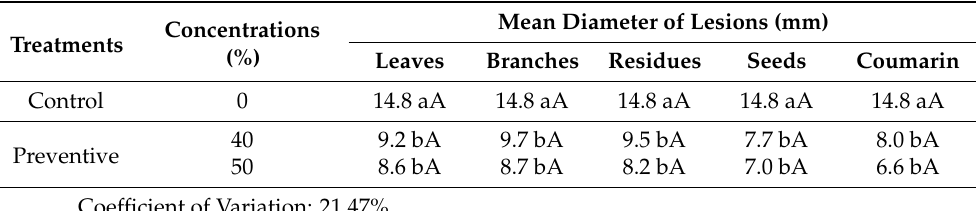
Coefficient of Variation: 21.47%